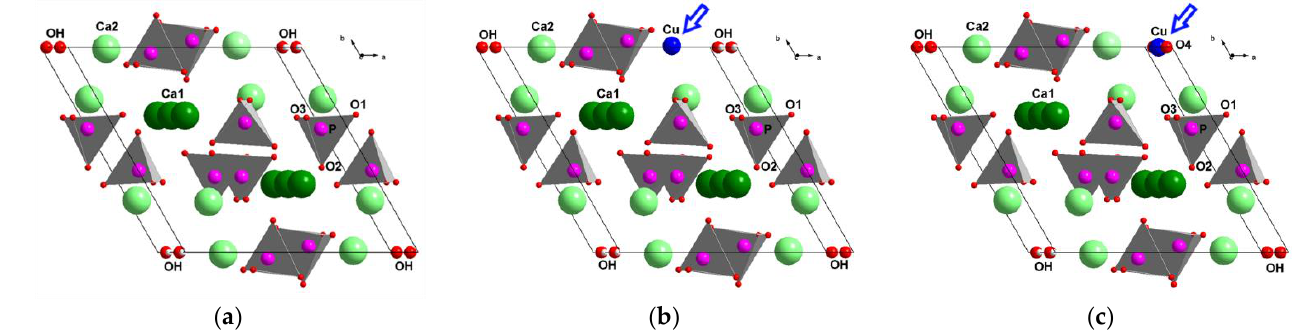
Figure 1. Crystal structure of stoichiometric HA ( a ) and of Cu-HA, featuring the localization of the copper cation either at the site of the calcium cation ( b ) or in the hydroxyl channel ( c ). The arrow indicates the position of the copper atom.